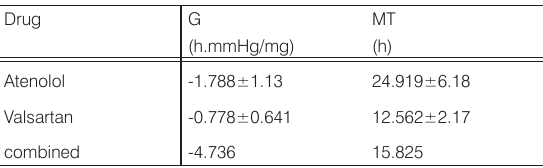
Table 8. The parameters of PD system for DP after separate and combined administration of atenolol and